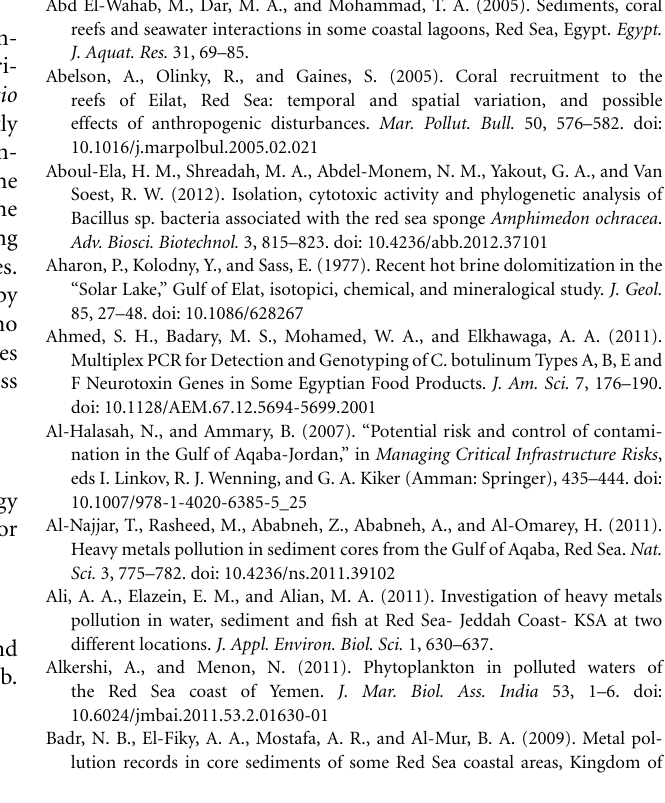
FIGURE 4 | Saline Lake bacterial consortia showing predominantly unknown species, including unknown species ( ∗ ) of Clostridium (29%), Marinobacter (24%), Halomonas (18%), Idiomarina (6%),